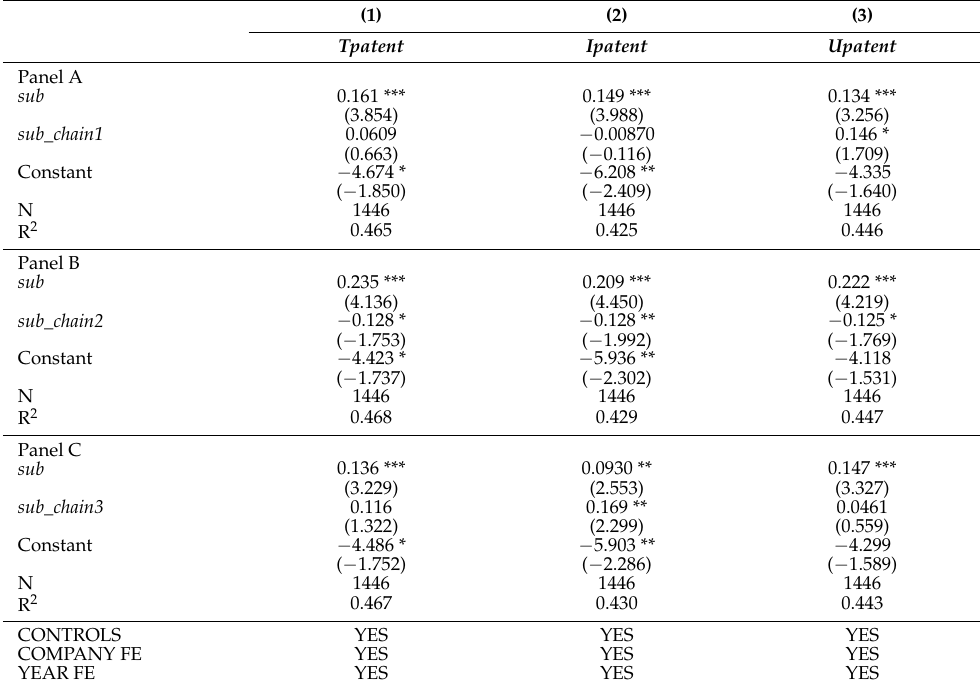
Table 12. Heterogeneity analysis: Comparison of inter-group coefficients of the industrial chain perspective (quantity of technological